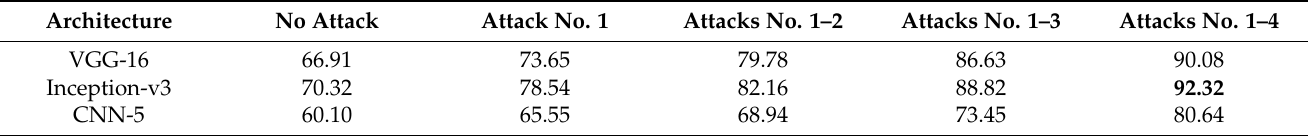
Table 4. Percentage of correct Kaggle.Dogs vs. Cats image recognitions without prevention of visual attacks.